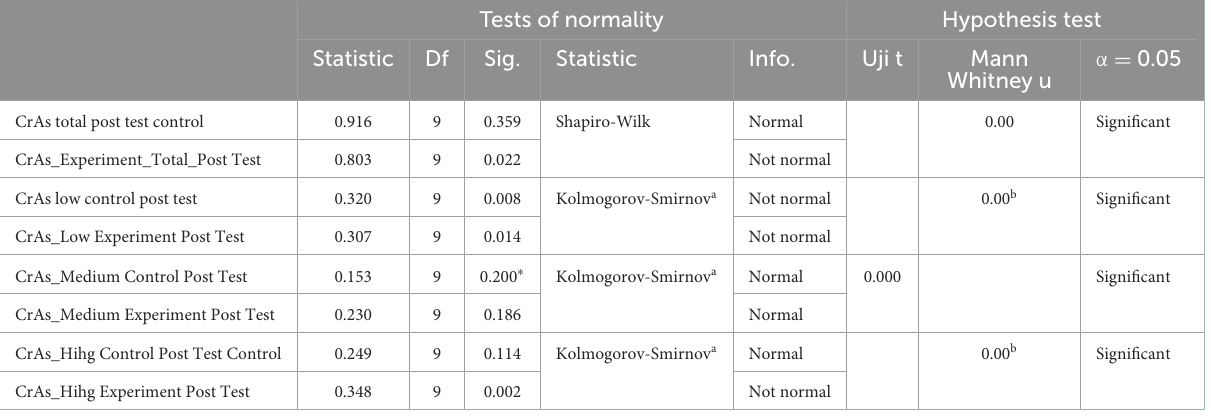
TABLE 5 Student critical thinking ability based on